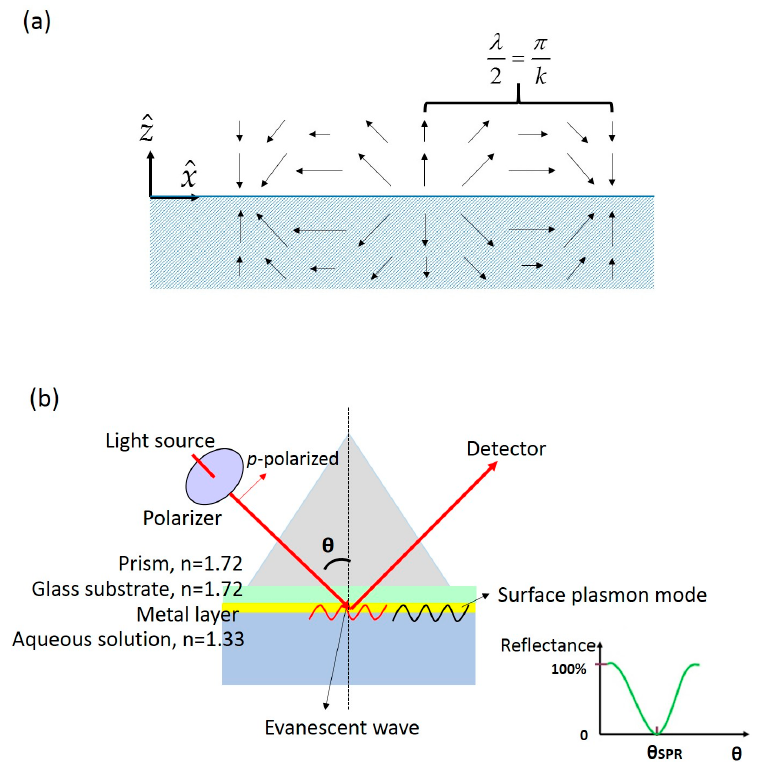
Figure 1. ( a ) A schematic illustration of the electrical field distribution of the surface plasmon at planar metal-dielectric interface; ( b ) the experimental setup of a typical surface plasmon resonance sensor in which a prism is used to produce the evanescent wave.